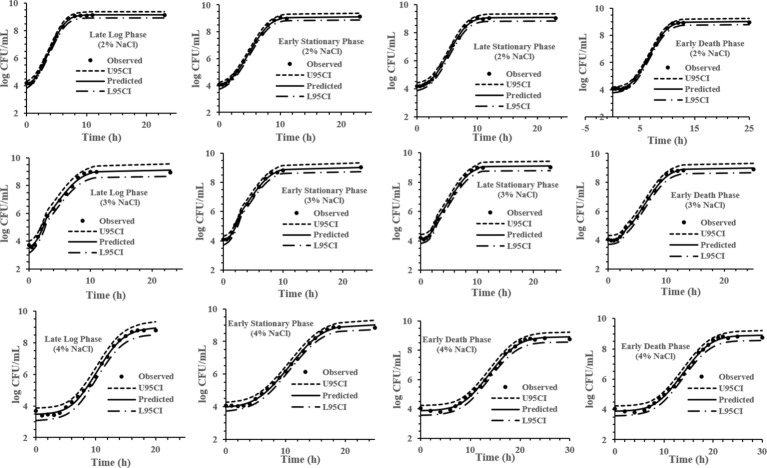
Baranyi model for S. Typhimurium DT104 in brain heart infusion (BHI) at salt concentration 2, 3, and 4% at 37°C. Observed, predicted, upper 95% confidence interval (U95CI) and lower 95% confidence interval (L95CI).